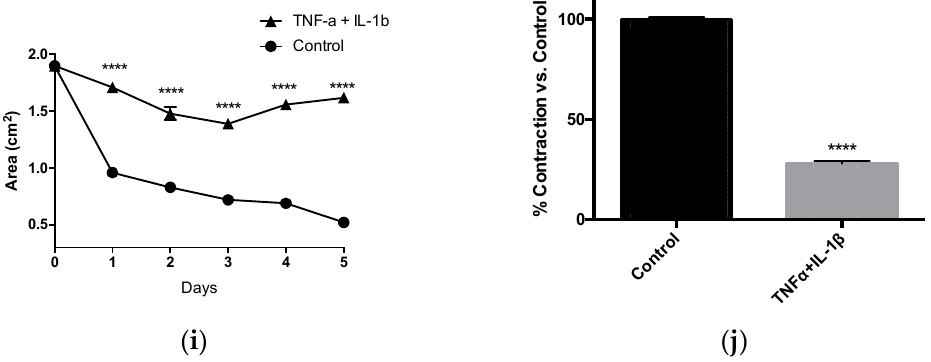
Figure 4. Inflammatory cytokines depress HBVSMC contractility . ( a ) 1000 U/mL of IFN treatment on HBVSMC resulted in greater area (measured in cm 2 ) after 3 days. ( b ) HBVSMC treated with 1000 U/mL of IFN for 4 days showed a signifi ‐ cantly lower contractility (expressed in % of contraction vs. control) compared with control treated HBVSMC. ( c ) 20 ng/mL of TNF treatment on HBVSMC resulted in greater areas after 1 day up to 5 days. ( d ) HBVSMC treated with TNF for 4 days showed a significantly lower contractility compared to control HBVSMC. ( e ) 20 ng/mL of IL ‐ 1b treatment on HBVSMC in collagen gel resulted in a larger area after 1 day up to 5 days. ( f ) HBVSMC treated with 20 ng/mL of IL ‐ 1b for 4 days showed a significantly lower contractility compared to control HBVSMC. ( g ) A combined treatment consisting of 1000 U/mL of IFN and 20 ng/mL of TNF on HBVSMC in collagen gel resulted in even greater areas (measured in cm 2 ) after 1 day. This effect persisted throughout the study (5 days). ( h ) HBVSMC treated with a combination of 1000 U/mL of IFN and 20 ng/mL of TNF for 4 days showed a significantly lower contractility. ( i ) A combined treatment consisting of 20 ng/mL of IL ‐ 1b and 20 ng/mL of TNF on HBVSMC in collagen gel resulted in a larger area (measured in cm 2 ) after 1 day. This effect persisted throughout the study (5 days). ( j ) HBVSMC treated with a combination of 20 ng/mL of IL ‐ 1b and 20 ng/mL of TNF for 4 days showed a significantly lower contractility. n = 3, ** p < 0.01, *** p < 0.001, **** p < 0.0001 versus control; Student’s t ‐ test; data are mean ± SEM.